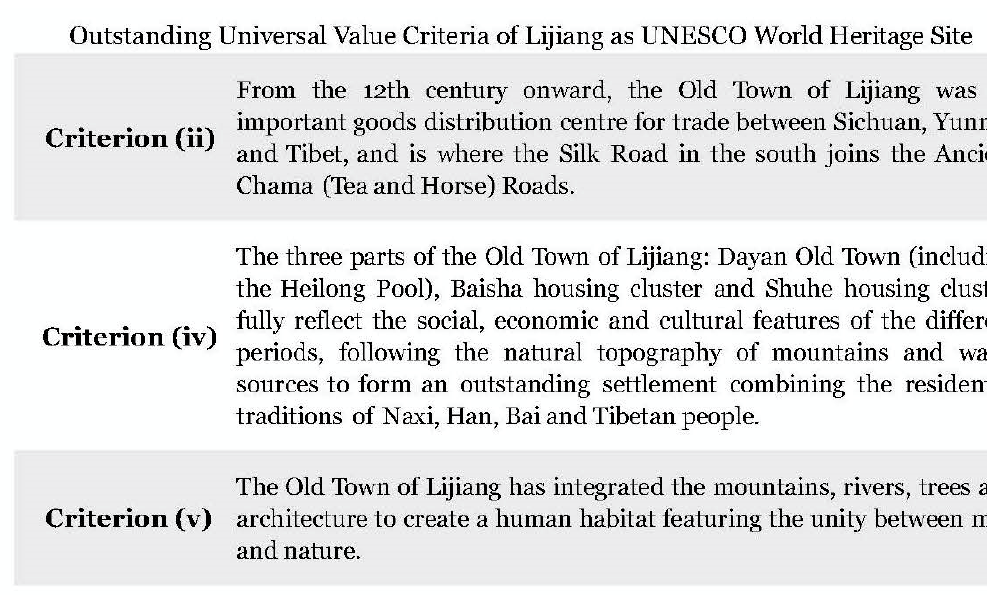
Figure 4. Outstanding universal Values of the UNESCO World Heritage site Old Town of Lijiang (from UNESCO World Heritage Centre website).